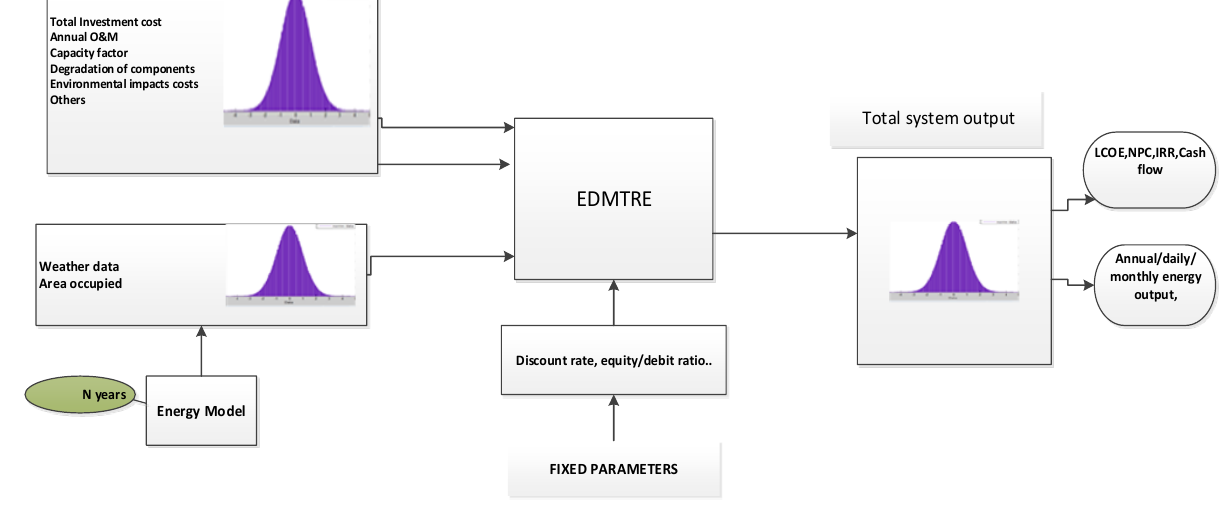
Figure 2. SPECA Model Block